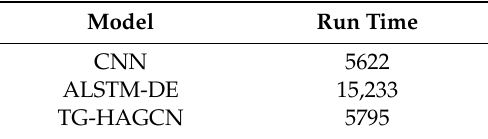
Table 4. Comparison of runtime (seconds).